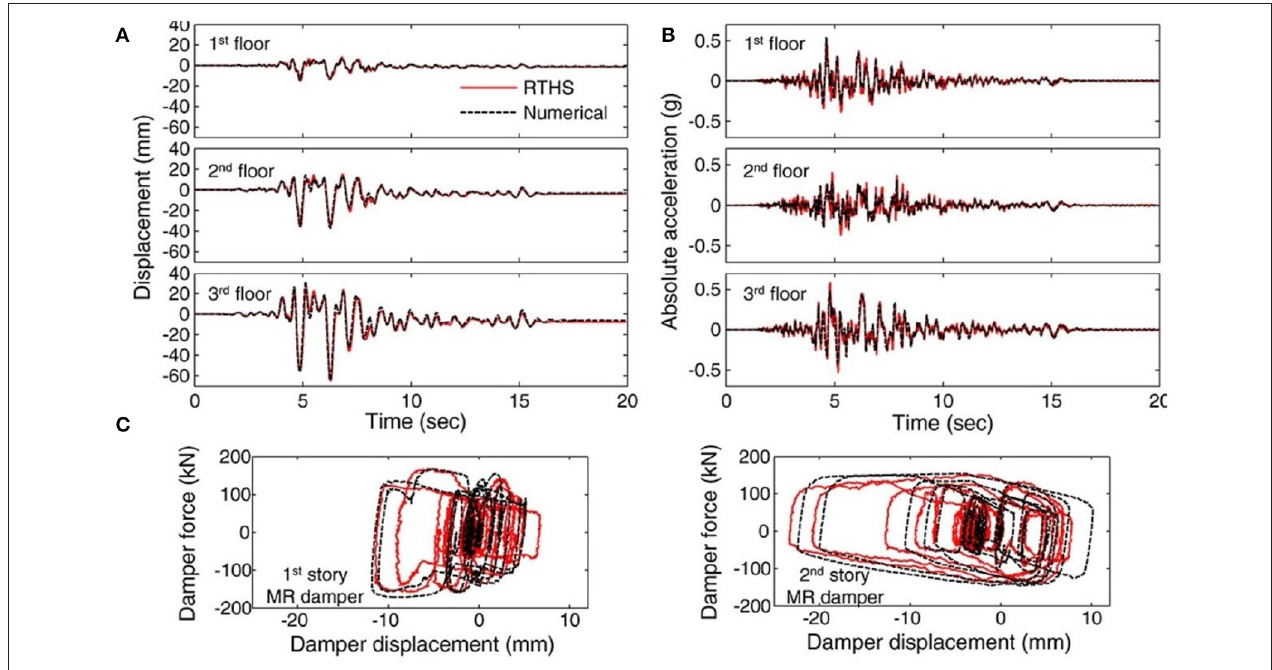
FIGURE 7 | Comparison between numerical simulation and RTHS results under the 80% DBE level 1994 Northridge earthquake: (A) floor displacement, (B) floor absolute acceleration, and (C) force-displacement response of MR dampers (reprinted from Chae et al., 2014 with